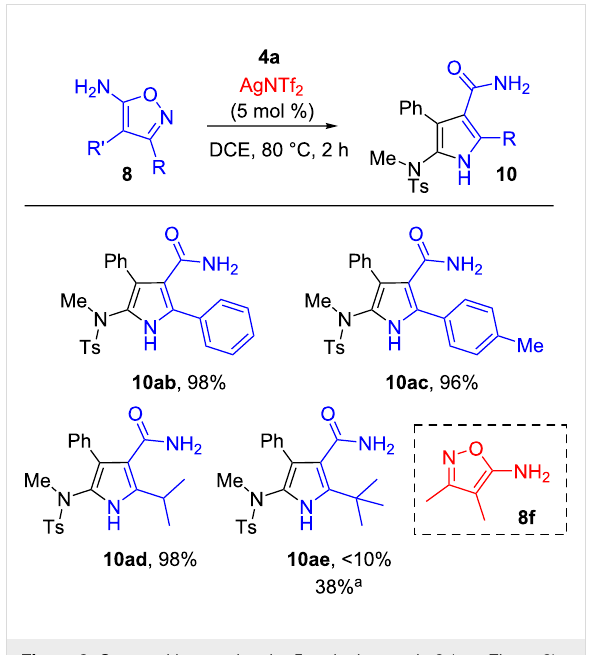
Figure 3: Scope with regard to the 5-aminoisoxazole 8 (see Figure 2). a Reaction conditions: 2.0 equiv of 8e , 100 °C.